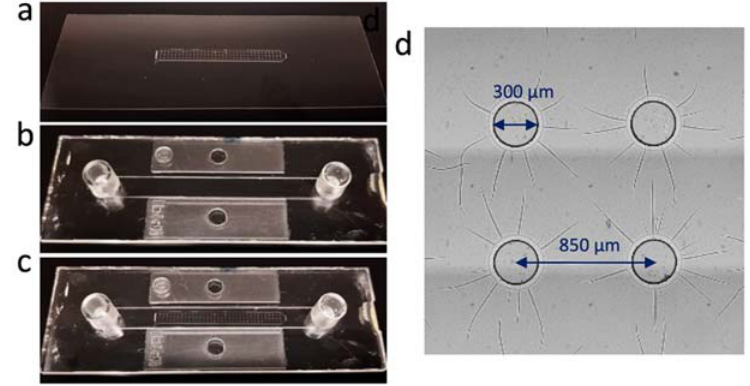
Figure 1. Construction of the microfluidic chip containing the cell microarray. ( a ) The bottom substrate: the SU-8 microwell array on the glass coverslip. ( b ) The top plate containing the channel, inlet and outlet (Ibidi, Gräfelfing, Germany). ( c ) The integrated microfluidic chip obtained by sticking the top plate to the bottom plate using double-sided sticky tape. ( d ) The microwells constructed by SU-8 UV ‐ photolithography.